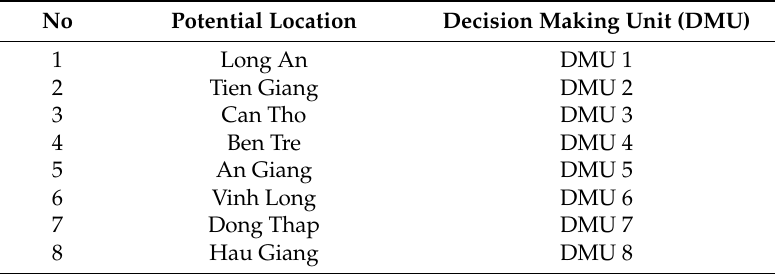
Table 5. Potential locations for building a solid waste to energy plant.